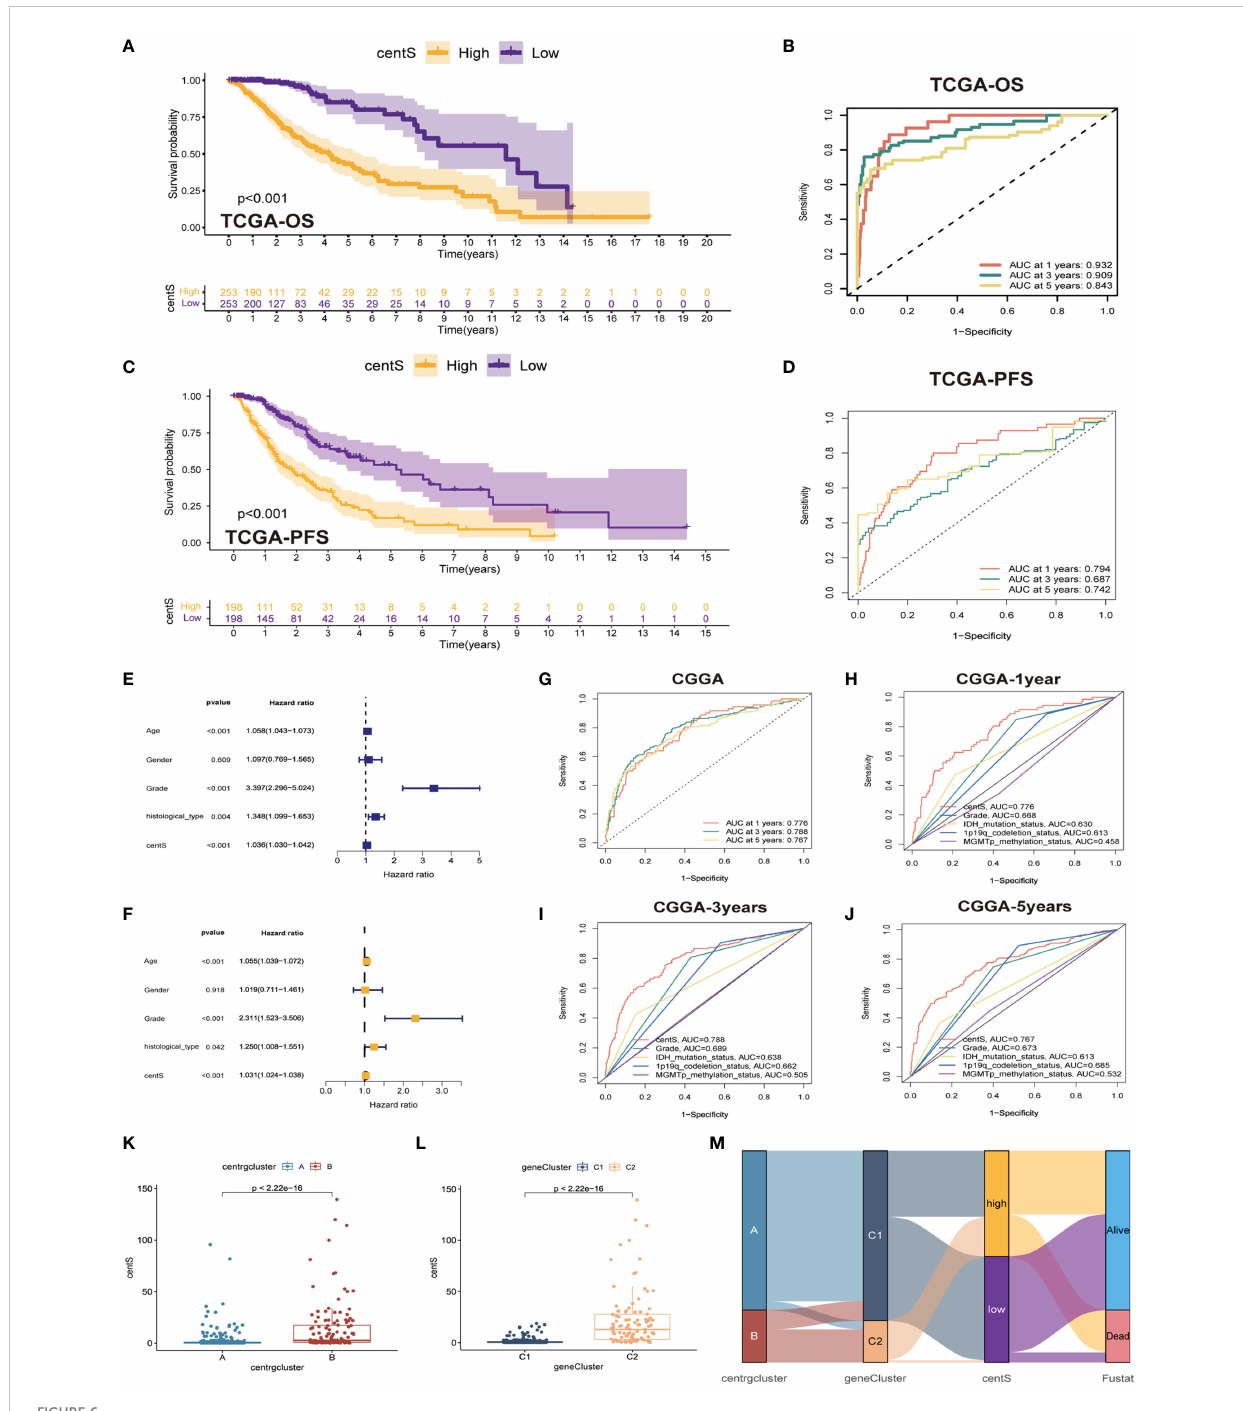
FIGURE 6 Construction and validation of centS and grouping based on centS. (A) OS analysis between the high- and low-centS groups in TCGA cohort. (B) ROC curves of centS in predicting OS at 1-, 3-, and 5-years in TCGA cohort. (C) PFS analysis between the high- and low-centS groups in TCGA cohort. (D) ROC curves of centS in predicting PFS at 1-, 3-, and 5-years in TCGA cohort. (E, F) Veri fi cation of the clinical independence of centS by univariate Cox regression analysis (E) and multivariate Cox regression analyses (F) . (G) ROC curves of centS in predicting OS at 1-, 3-, and 5-years in CGGA cohort. (H – J) ROC curves of centS and other LGG prognostic molecules (grade, IDH mutation status, 1p19q codeletion status, and MGMTp methylation status) in predicting OS at 1-, 3-, and 5-years in CGGA cohort. (K) Differences in centS levels between the two CRGs subtypes. (L) Differences in centS levels between the two gene-subtypes. (M) Sankey diagram to show the correspondence among subtypes, gene-subtypes, centS and survival outcomes. centS, centrosome score; CRGs, centrosome related genes; DEGs, differentially expressed